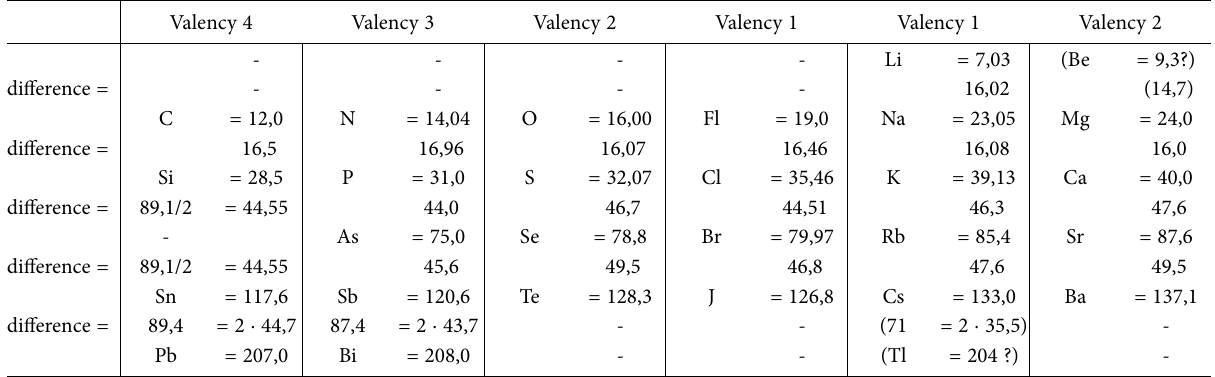
Figure 2. Meyer’s table of “well-characterized groups of elements”. Adapted from L. Meyer, Die modernen Theorien der Chemie und ihre Bedeutung für die chemische Statik, Maruschke & Berendt, Breslau, 1864 , p. 137.